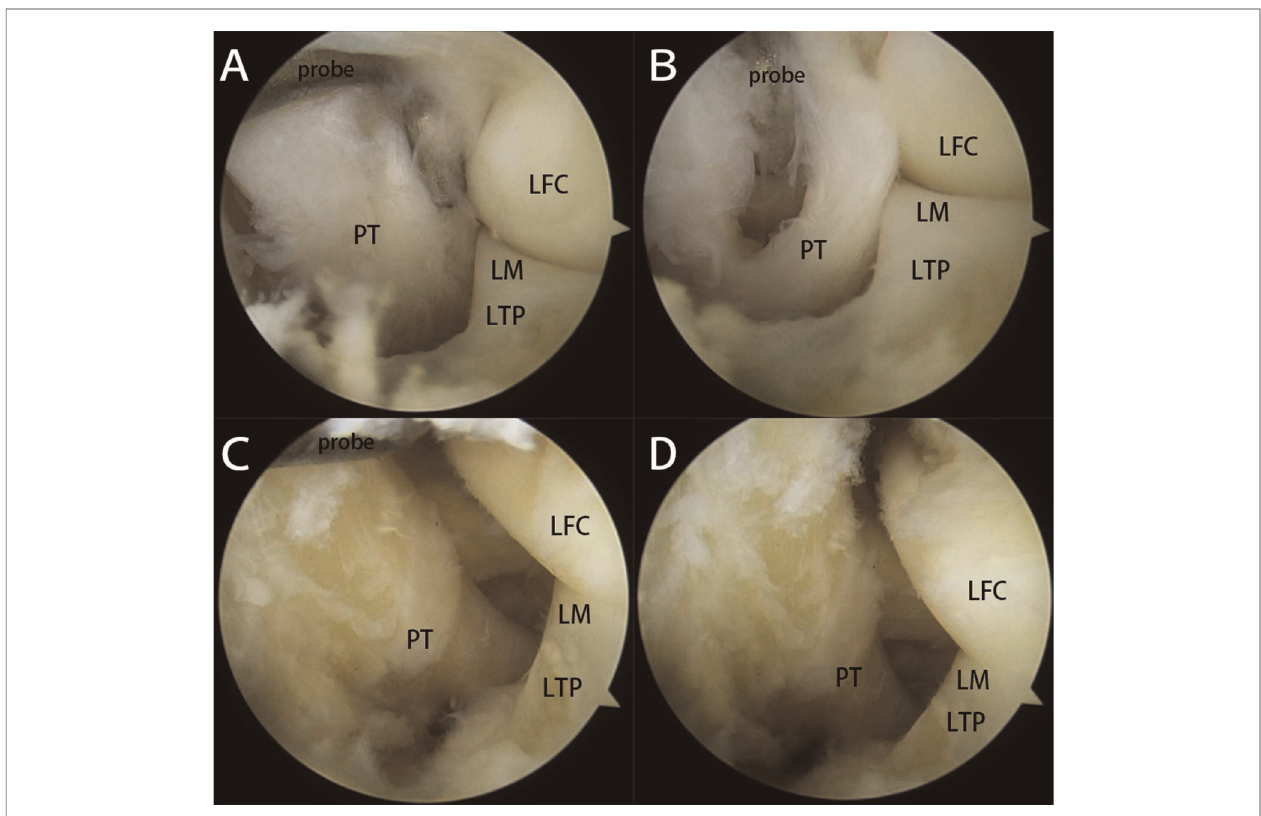
FIGURE 5 | The arthroscopic fi nding of the popliteus tendon and popliteus hiatus via an auxiliary extreme lateral approach. ( A , B ) Before ablation: The arthroscopic fi nding of the popliteus tendon and popliteus hiatus (PT, popliteus tendon; LM, lateral meniscus; LFC, lateral femoral condyle; LTP, lateral tibial plateau). ( C , D ) After